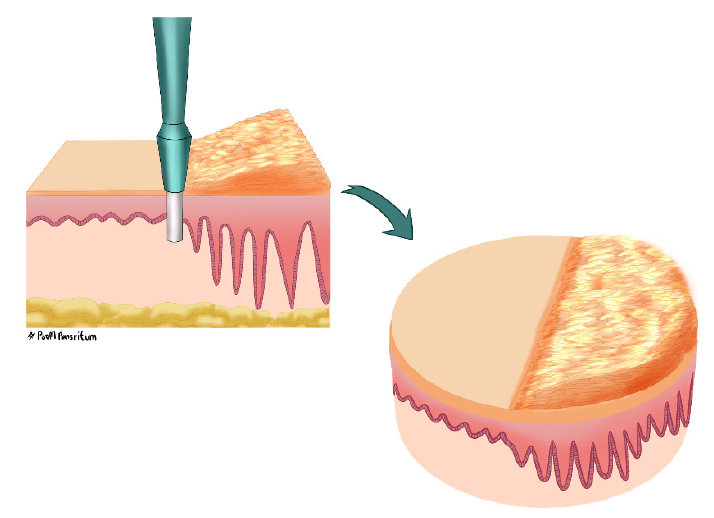
Figure 9. Peripheral edge of the lesional skin. The biopsy landmark was identified by the well-demarcated edge of the plaque. The piece of biopsy included equal sides of normal phenotypic skin and lesional skin.